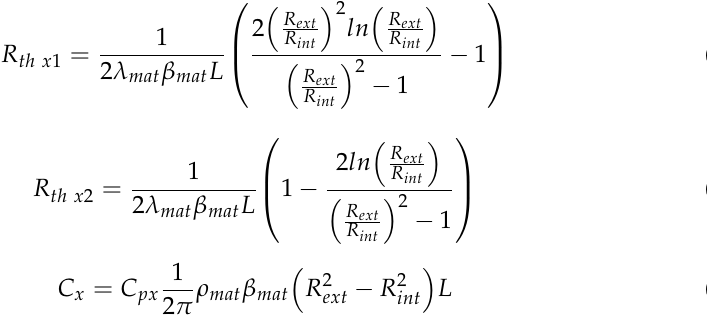
Table 2. Materials thermal conductivities. Material Thermal Conductivity λ Iron 25 Slots (average thermal conductivity of an equivalent homogeneous material with copper and insulation) air